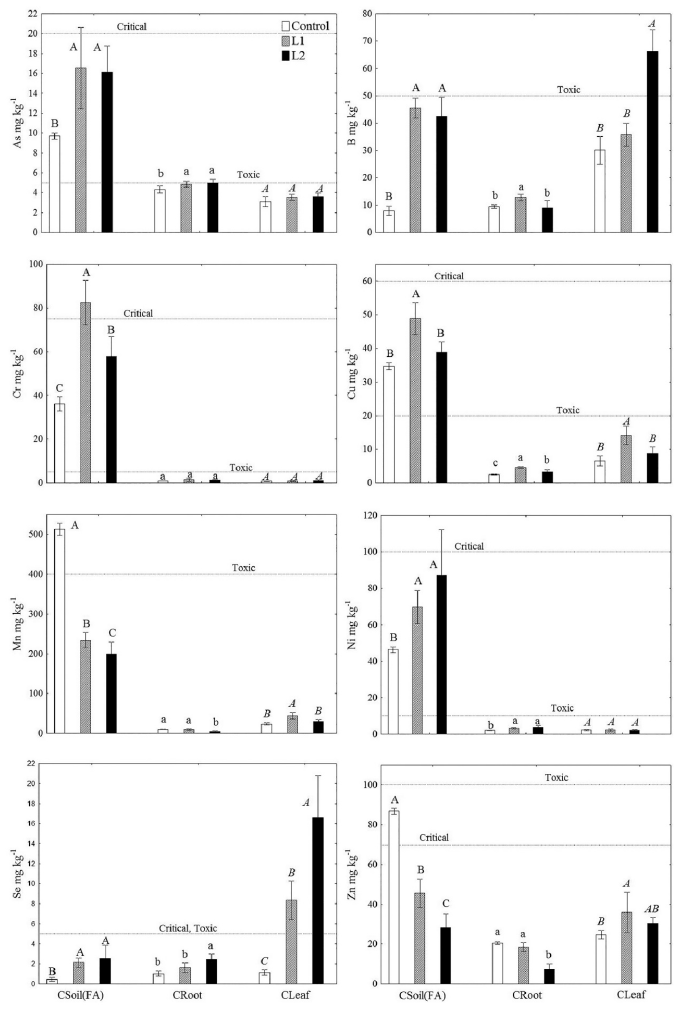
Figure 2. Pseudo total concentrations of heavy metal(loid)s in soil (CSoil) and FA (CFA), and total concentrations in roots (CRoot) and leaves (CLeaf) of T. tetrandra ( n = 15). Critical—critical concen- trations in soil [34]; Toxic—toxic concentrations in plant tissue [35]. Different letters indicate significant difference between sites at p < 0.001 (Capital Normal—soil/FA; lower case normal—root; Capital Italic —leaf).